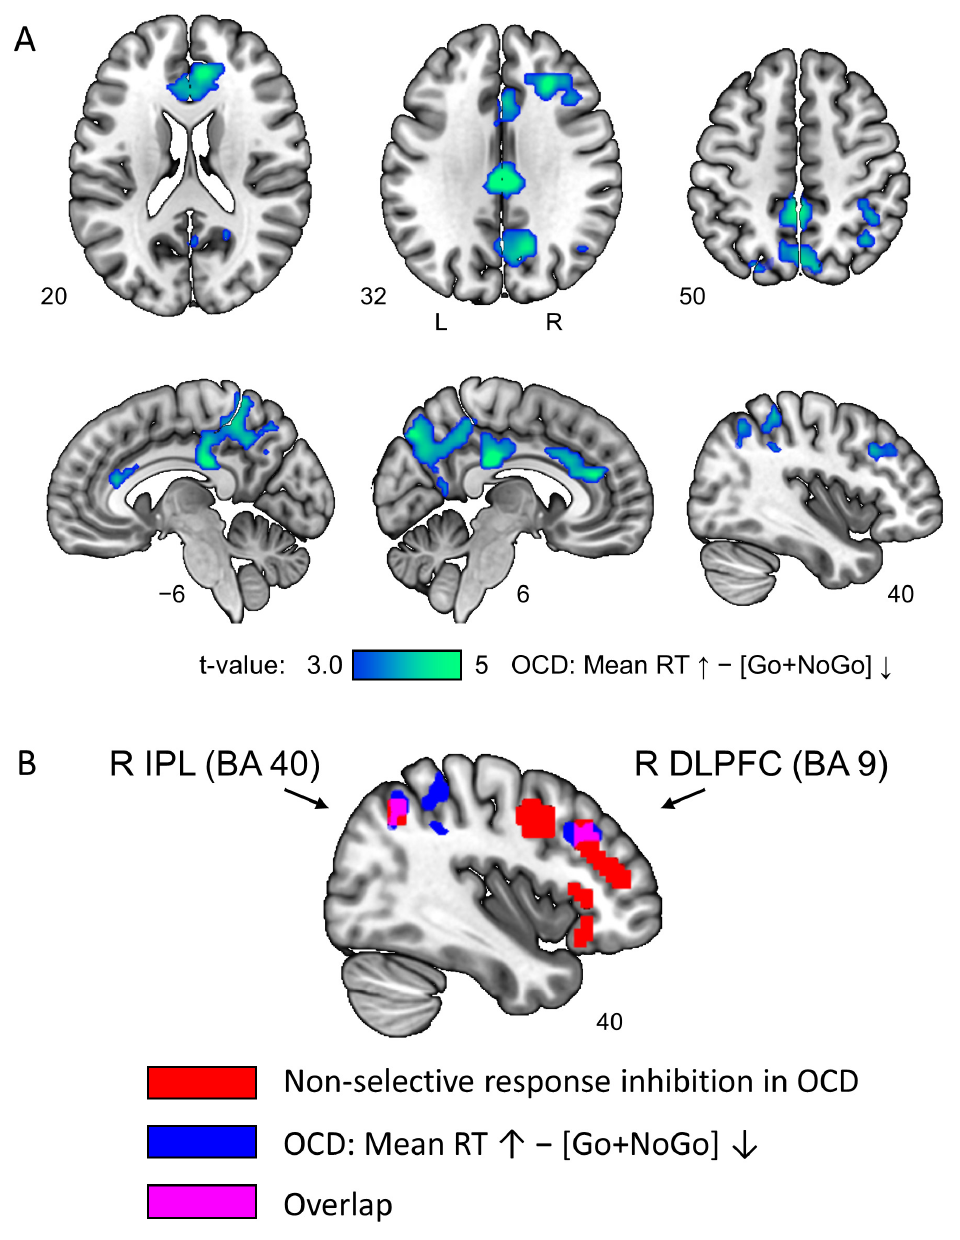
Figure 4. ( A ) Inverse dependency between patients’ mean RT and brain activity in equiprobable Go and NoGo trials (“Go + NoGo” contrast). Cluster-level FWE-corrected threshold of 0.05. ( B ) Nodes of the non-selective response inhibition system in patients with OCD (red color), brain areas associated with response slowness in OCD (blue color), and the overlap between them (violet color).